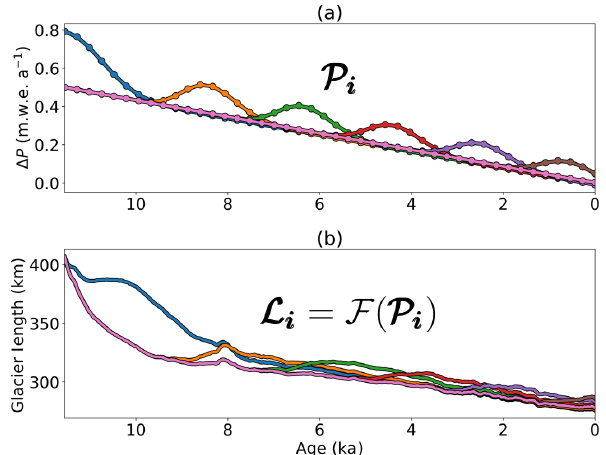
Figure 3. (a) A subset of 6 out of a total of 45 Menegaz et al. (2011) sigma points P i representing different precipitation anomaly his- tories. (b) Six corresponding glacier length histories L i or trans- formed sigma points obtained by inputting the sigma points P i into the ice dynamics model F .